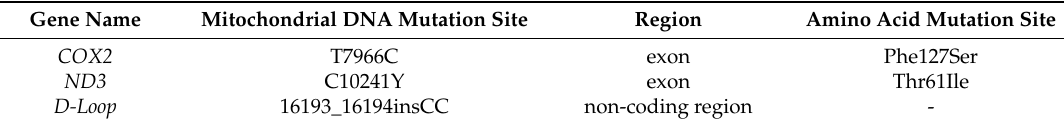
Table 1. Mutation sites in the mitochondrial DNA sequences of MOLT-3/IDR cells.